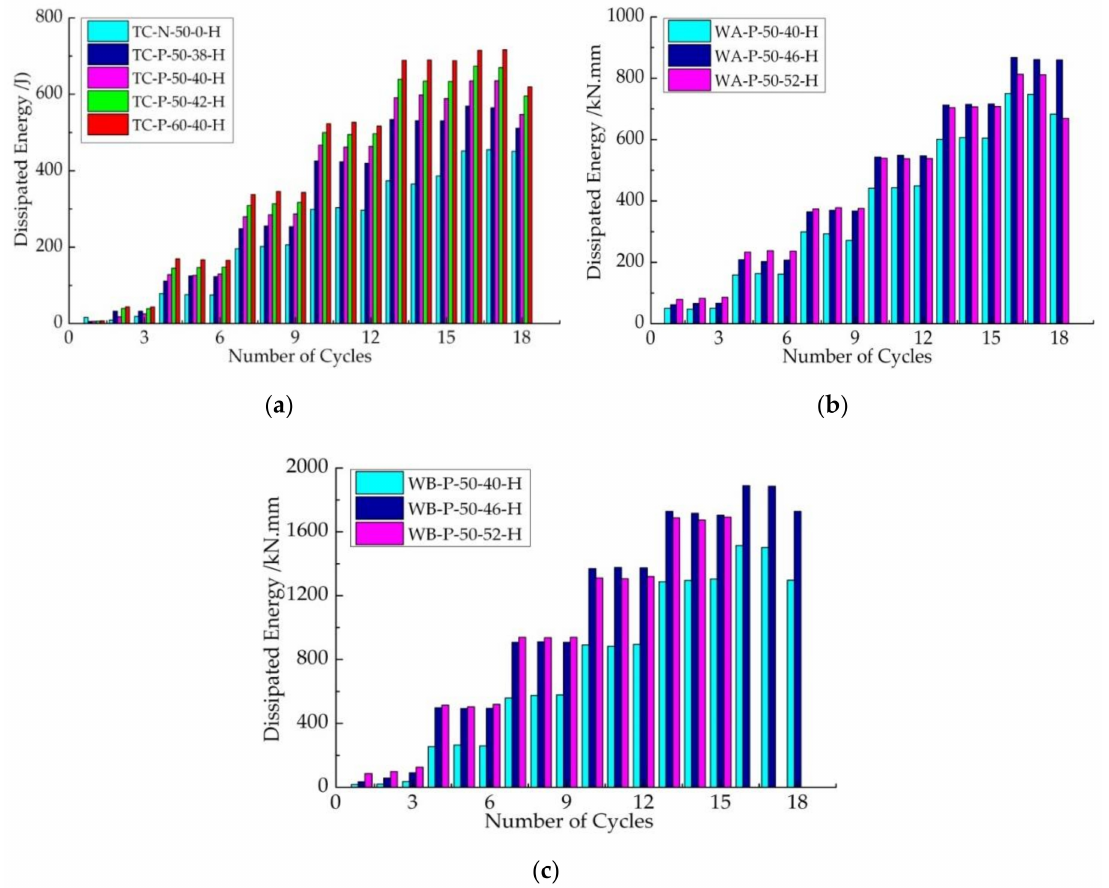
Figure 11. Energy dissipated by specimens at each cycle represent specimens from groups ( a ) TC, ( b ) WA and ( c )